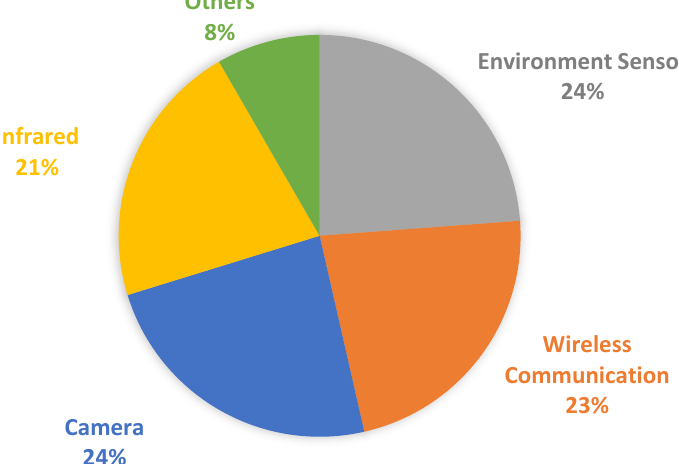
Figure 5. The proportion of occupancy measurement systems used.